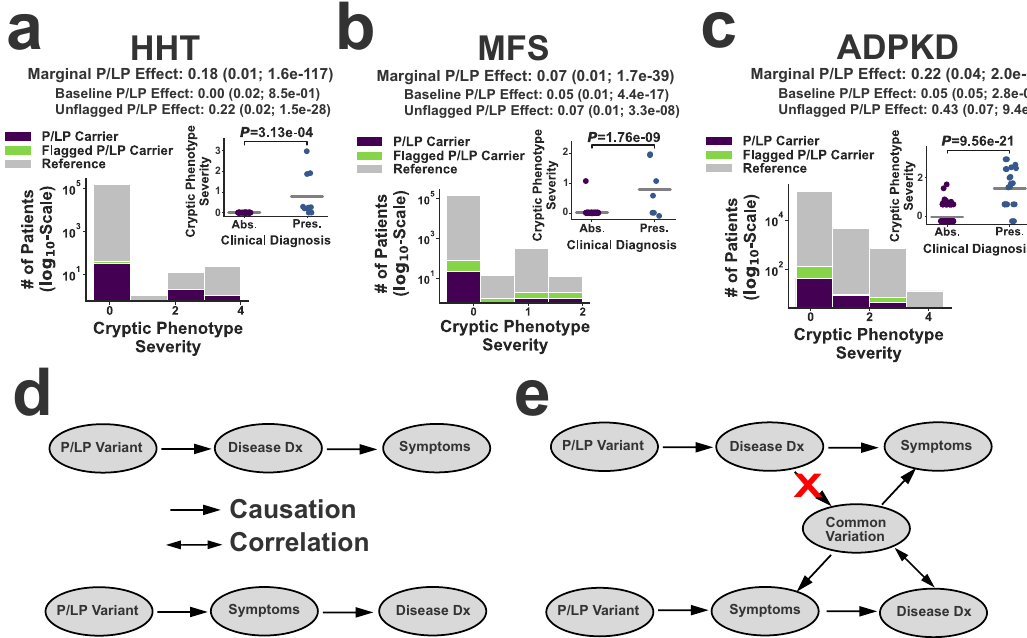
Fig. 3 Exome-sequencing validation of the inferred cryptic phenotypes. Panels a – c Histograms depicting the distribution of cryptic phenotype severity across three different genotypes in the UKBB: reference (gray), P/LP Carrier (purple), and Flagged P/LP Carrier (green). The marginal P/LP cryptic phenotype effect sizes (includes fl agged and un fl agged variants) are provided at the top of each panel. The decomposed baseline and un fl agged variant effects are displayed below the marginal effects. Parentheses contain the standard errors and P -values for the effects. These statistics were estimated using linear regression and two-sided T -tests (see the “ Methods ” section). The insets display the cryptic phenotype severity estimates among the P/LP carriers for each condition, strati fi ed by whether the rare disease diagnosis is absent (Abs.) or present (Pres.). Gray bars represent the mean values within each diagnostic class, and P -values were computed using linear regression (with Clinical Diagnosis included as a predictor) and two-sided T -tests. No adjustments were made for multiple testing. a Hereditary hemorrhagic telangiectasia (HHT; N = 153,182 independent subjects). b Marfan syndrome (MFS; N = 153,182 independent subjects). c Autosomal dominant polycystic kidney disease (ADPKD; N = 153,182 independent subjects). d Illustration of the two biases that could lead to increased cryptic phenotypes among diagnosed carriers. Top: post-diagnosis con fi rmation bias. Bottom: pre-diagnosis ascertainment bias. e Common variant modi fi ers could be used to distinguish between these competing models, as common variation would only be correlated with disease diagnosis under the ascertainment bias